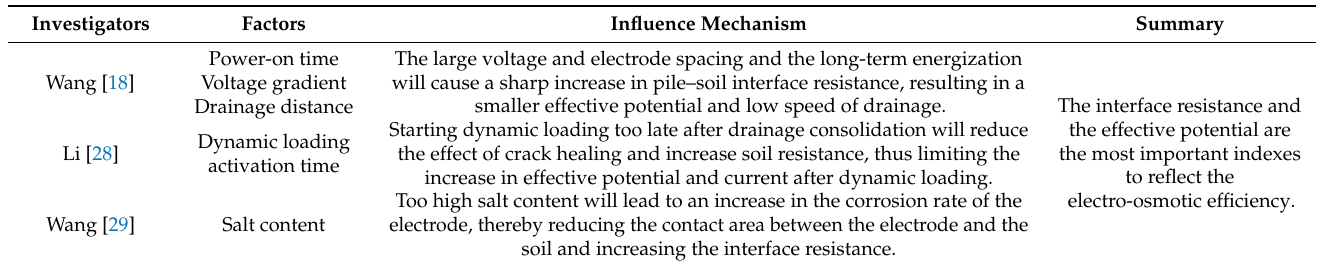
Table 1. Summary of influencing factors of electro-osmosis.